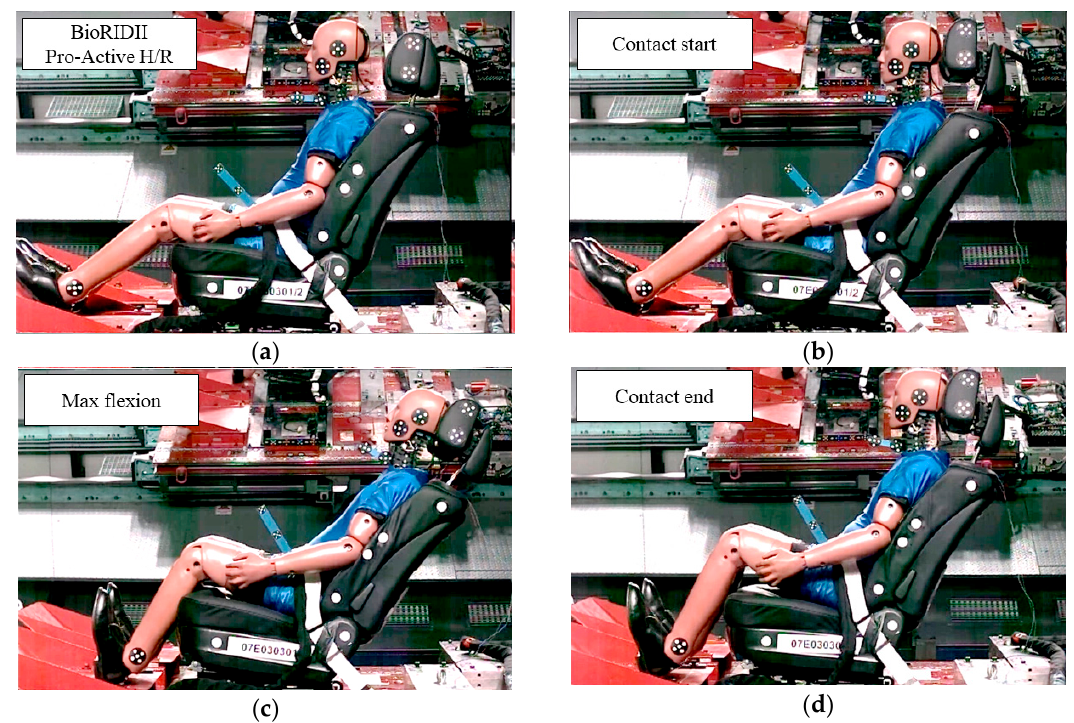
Figure 8. Images of proactive headrest during the sled test: ( a ) initial setting (0 ms); ( b ) contact start (30 ms); ( c ) maximum flection (135 ms); ( d ) contact end (90 ms). Appl. Sci. 2020 , 10 , x FOR PEER REVIEW